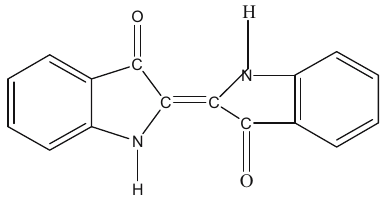
Figure 5: The structure of the